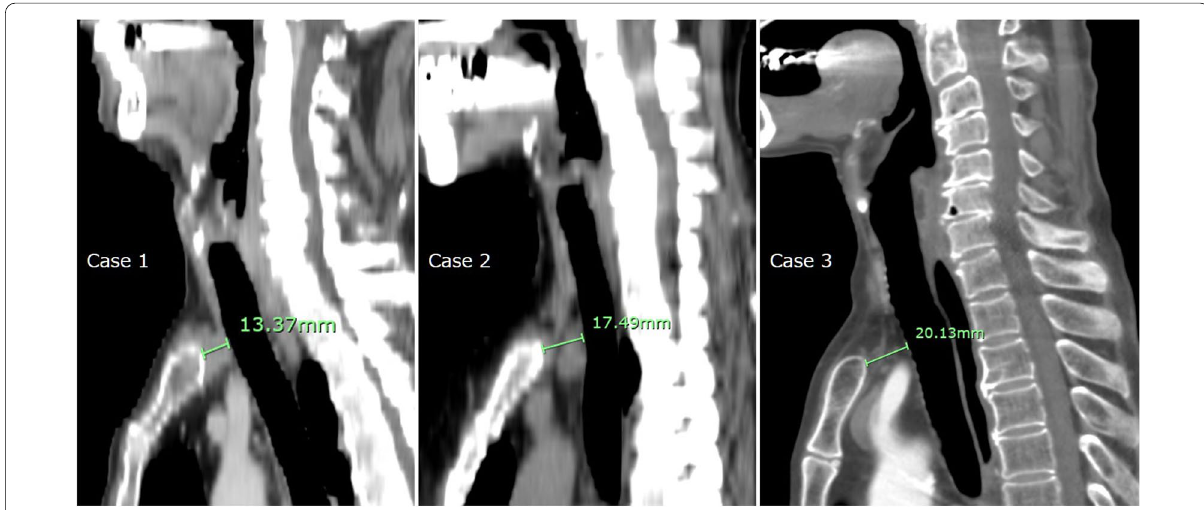
Fig. 4 Measurement of the sterno-tracheal distance (STD) in each case. The STD was defined as the minimum distance from the sternum to the anterior wall of the trachea in the sagittal section of cervical chest on preoperative computed tomography scans. None of the cases had an STD < 13 mm